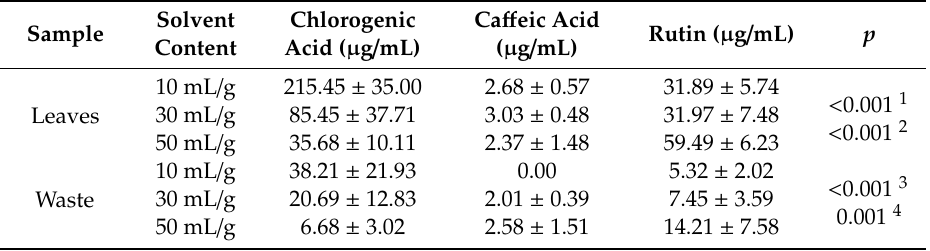
Table 7. The di ff erence in the contents of bioactive compounds depending on the amount of solvent used for the extraction.